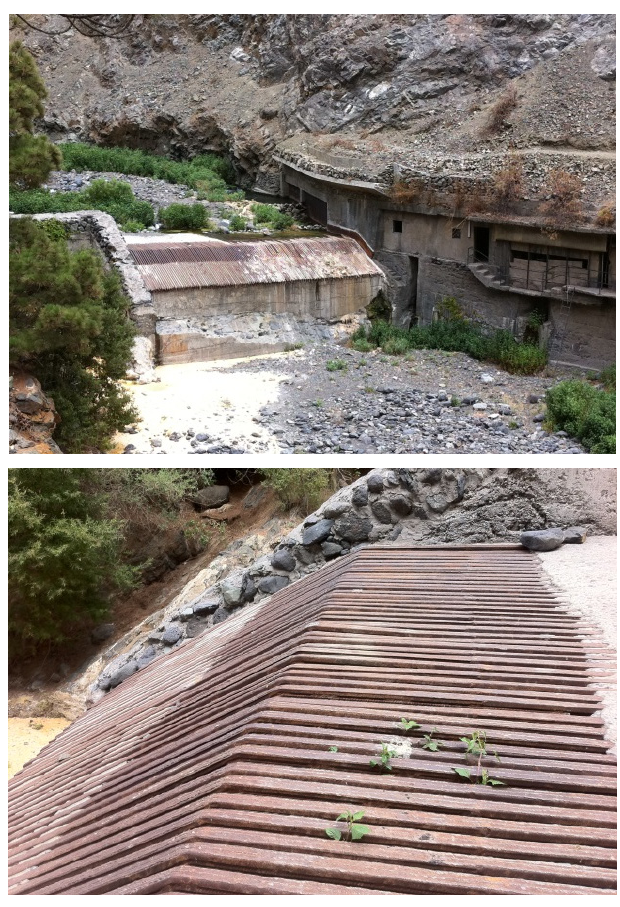
Figure 1. Bottom rack intake at the riverbed of Las Angustias Gully—Caldera de Taburiente, located in La Palma Island (Canary Islands, Spain).